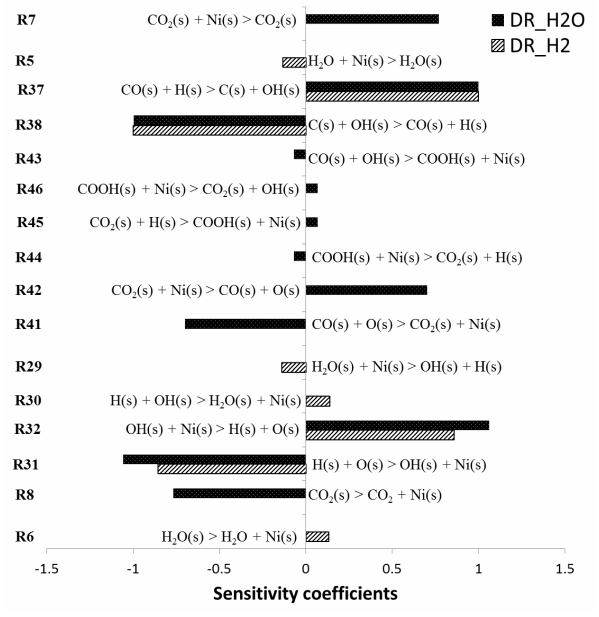
Figure 17. Sensitivity analysis of C(s) formation for dry reforming in the presence of H 2 and H 2 O at 1123